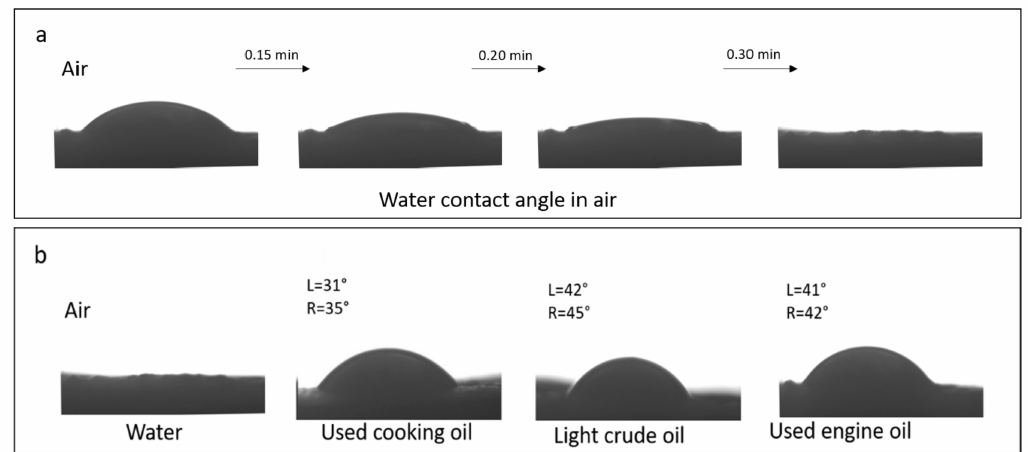
Figure 9. Modified (1:7) chitosan–gelatin membrane wetting behavior: ( a ) water wettability and ( b ) oil wettability in